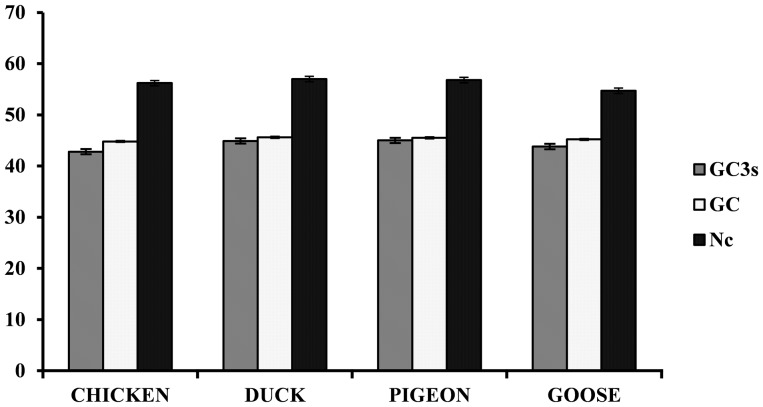
Improved effective number of codons index (Nc) as a measure of overall average codon usage bias (CUB) in four different species.The actual mean Nc, mean GC3s and mean GC calculated at 95% confidence.